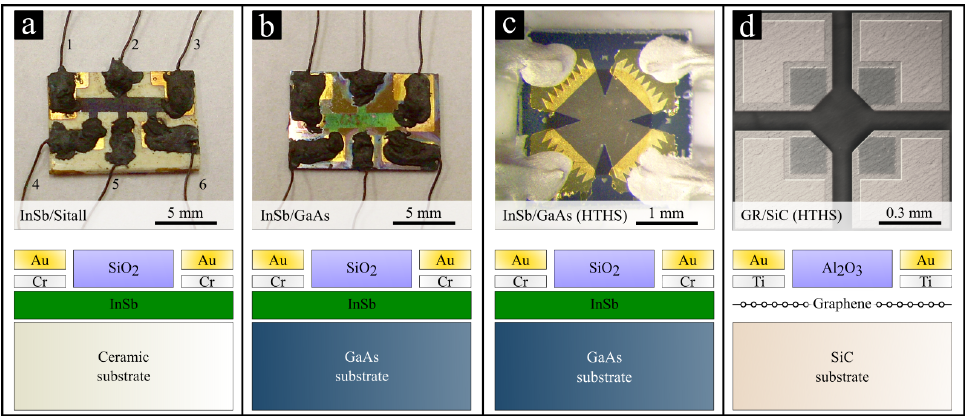
Figure 1. Schematics and optical images of the fabricated Hall effect structures ( a ) InSb/Sitall ( b ) InSb/GaAs ( c ) n-InSb (HTHS) ( d ) QFS GR/SiC